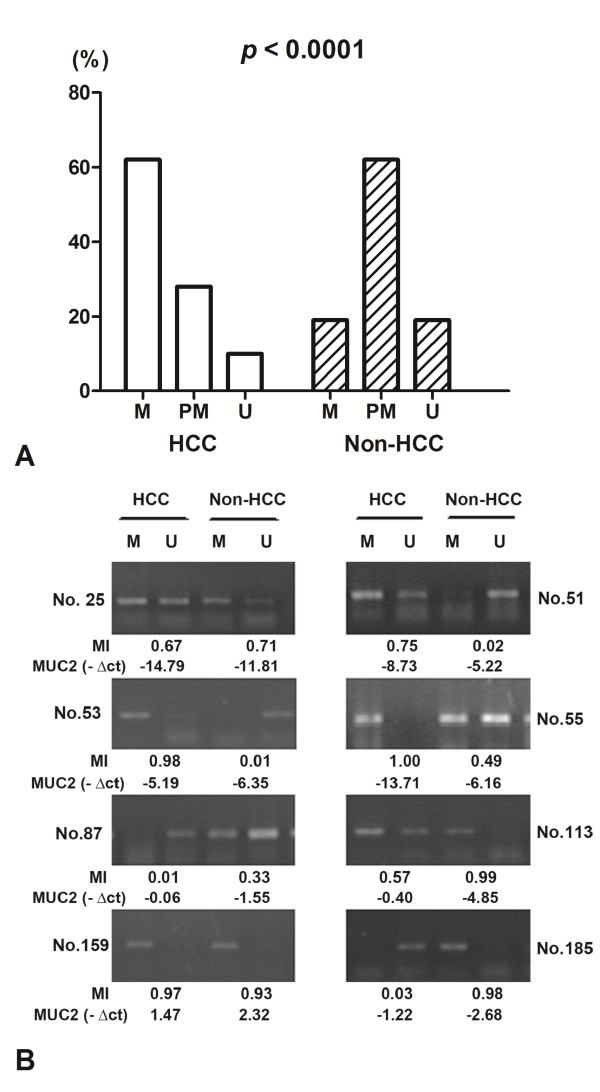
The promoter methylation of MUC2 in HCC tissues and non-tumor tissues by MSP. (A) Methylation of MUC2 promoter in HCC and corresponding non-carcinoma tissues. M, hypermethylation; PM, partial methylation; U, unmethylation; (B) Representative patterns of MUC2 promoter methylation. U, reaction specific for unmethylated DNA; M, reaction specific for methylated DNA. MI, The methylation index. -ΔCt, - (CTMUC2 - CTβ-actin).